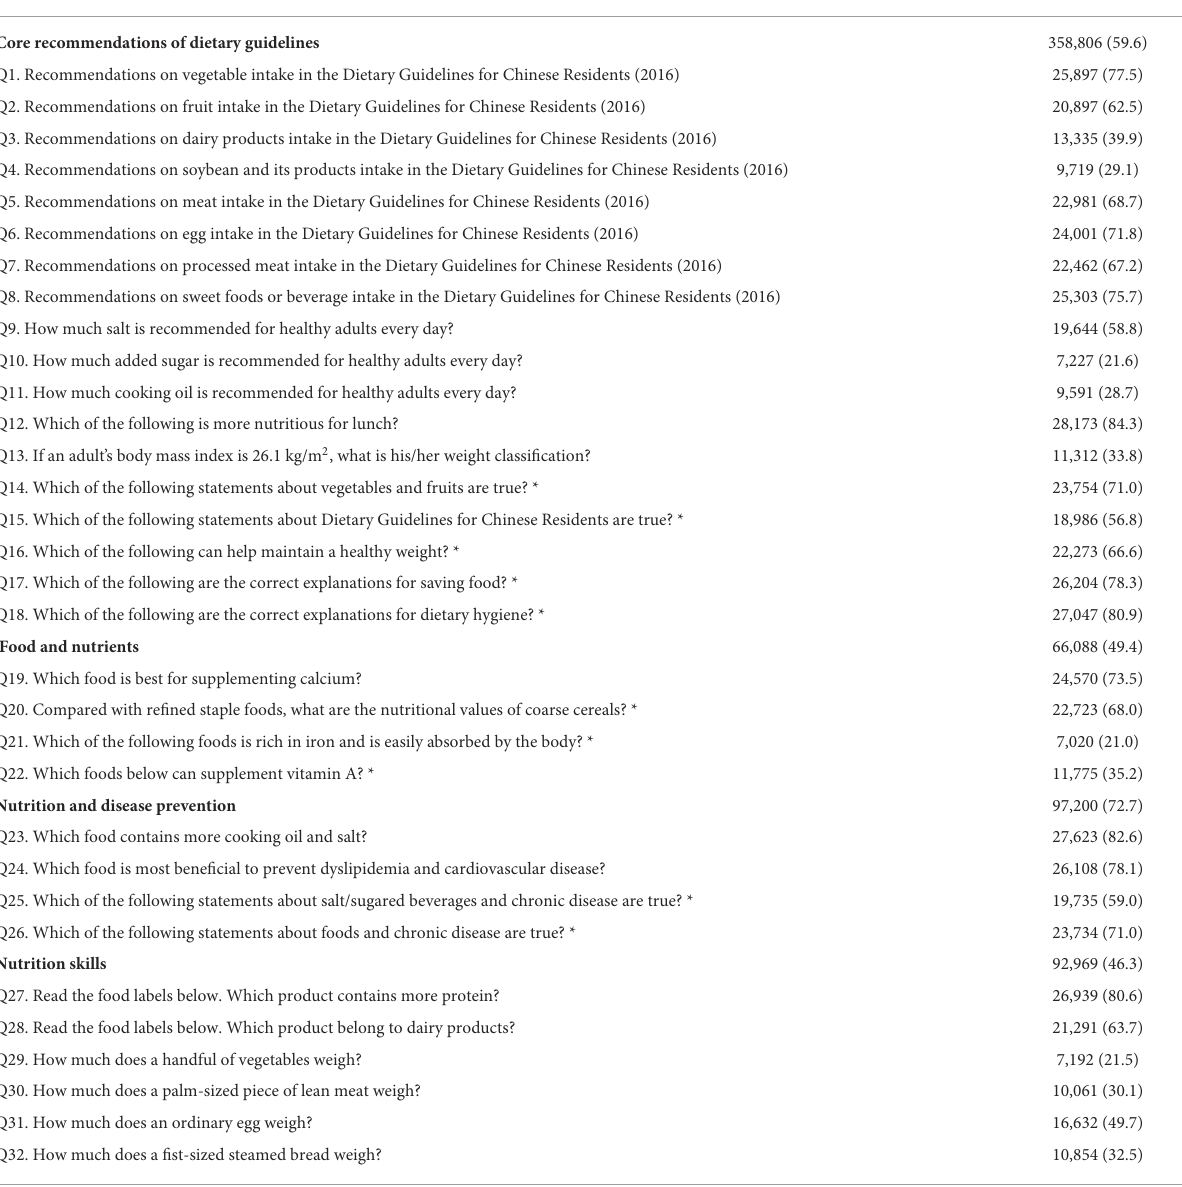
TABLE 2 Awareness rate of nutrition and health knowledge of